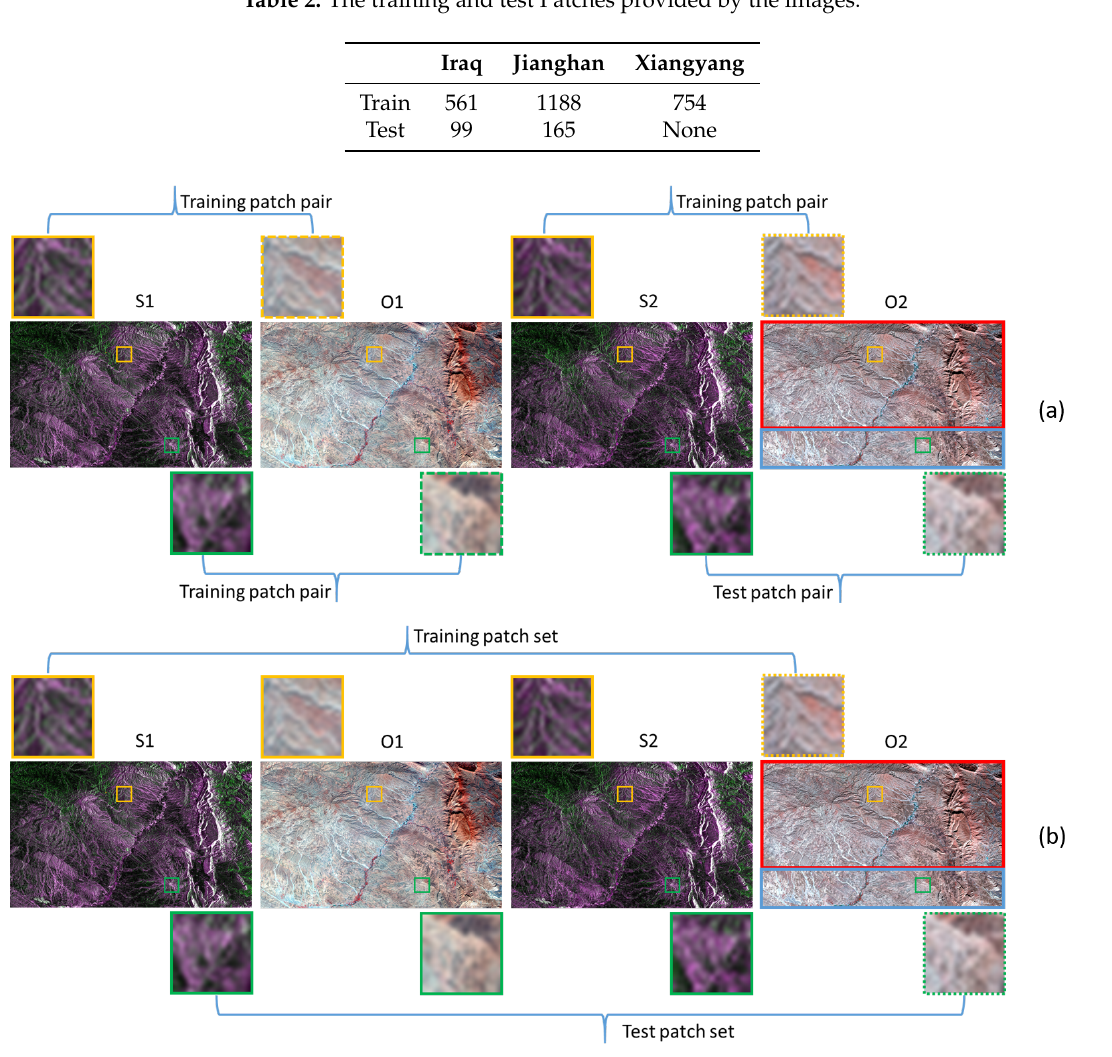
Table 2. The training and test Patches provided by the images.